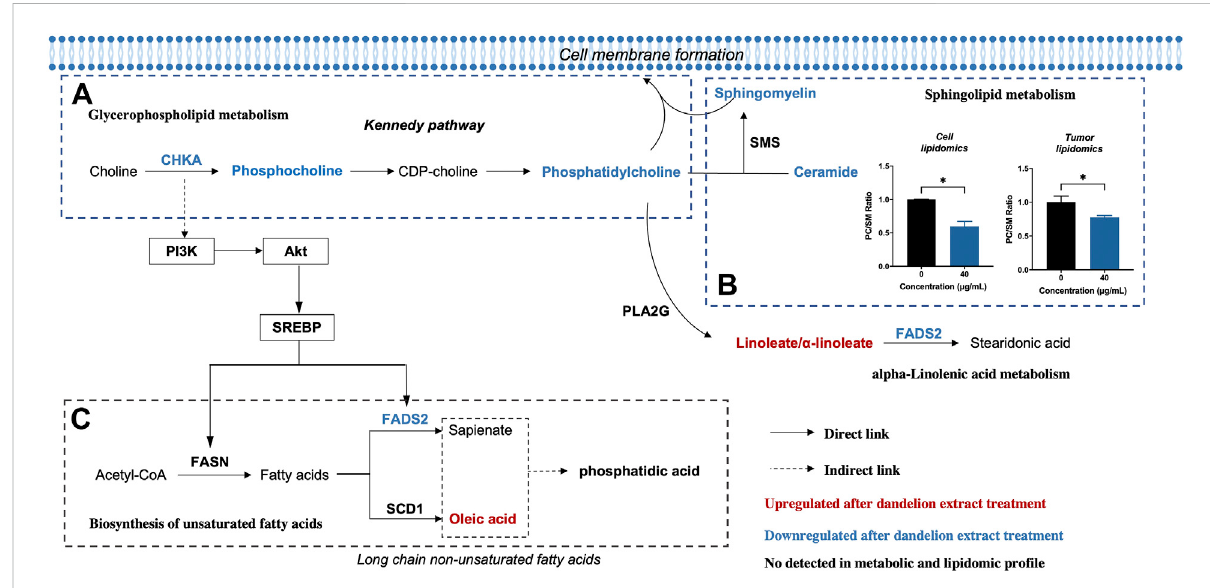
FIGURE 6 Altered metabolic pathways of MDA-MB-231 cell after dandelion extract treatment. (A) The Glycerophospholipid metabolism. (B) The Sphingolipid metabolism. (C) The biosynthesis of unsaturated fatty